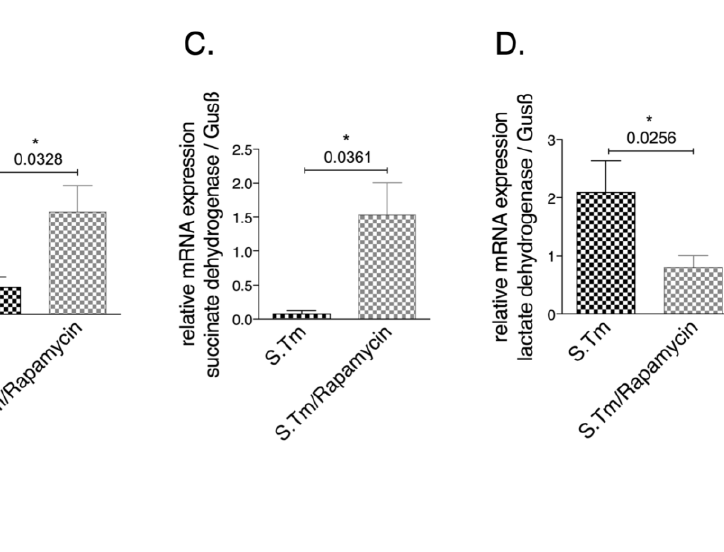
FIGURE 5: Effects of mTOR inhibition on relative expression of metabolic enzymes in Salmonella infected